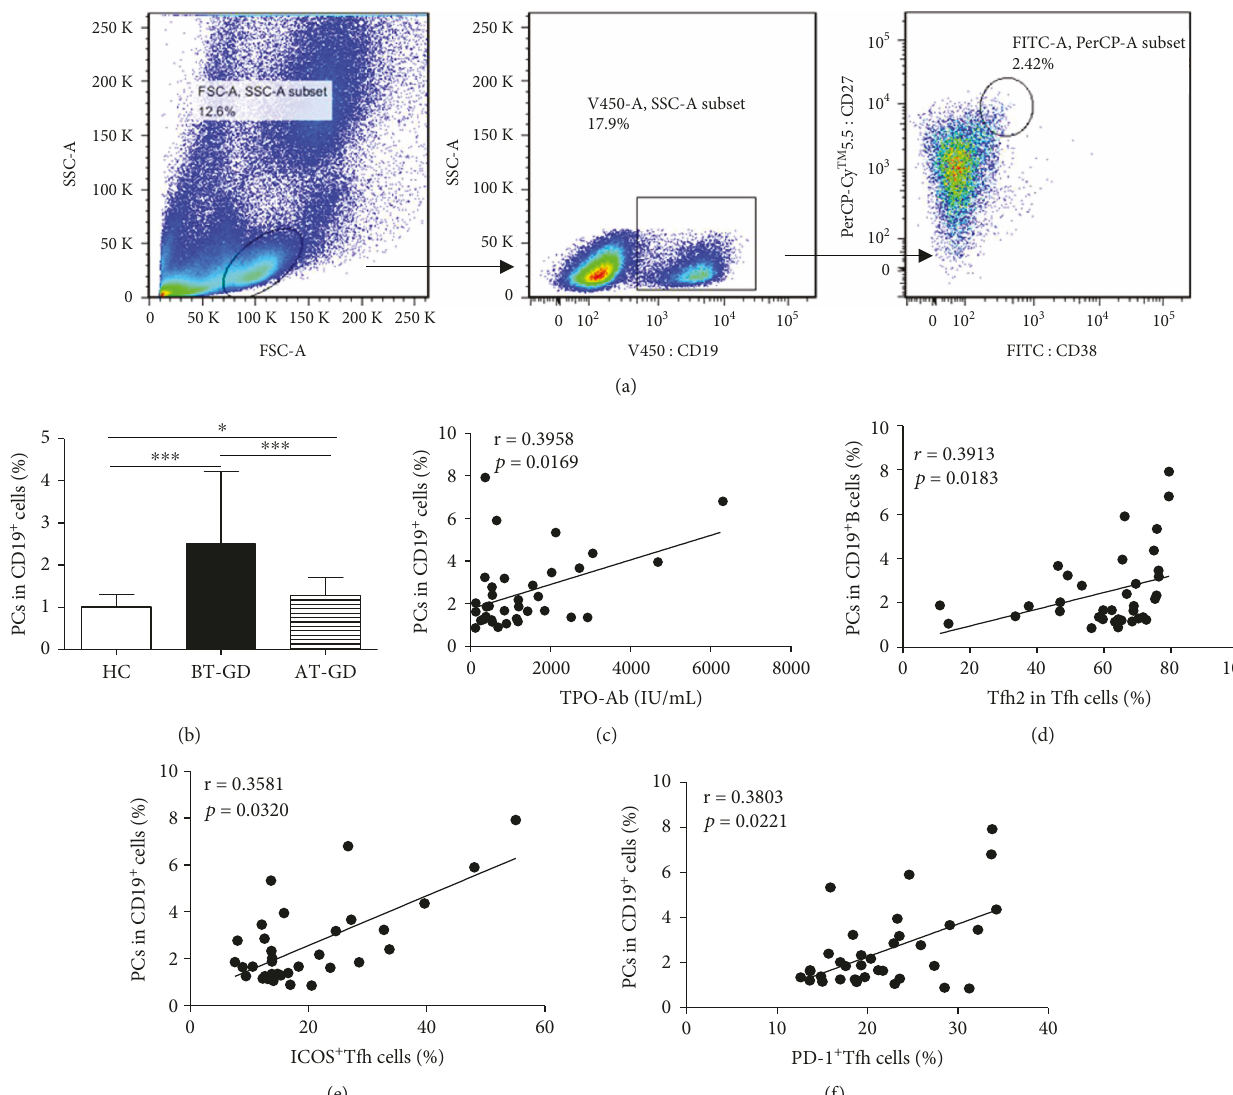
Figure 3: Expanded frequency of circulating plasma cells in GD patients. Human PBMCs from GD patients (BT: 36; AT: 21) and 20 HC were stained with anti-CD19, anti-CD38, and anti-CD27. (a) The cells were gated initially on lymphocytes and then on CD19 + B cells; afterwards, the numbers of CD27 high CD38 high PCs were analyzed by fl ow cytometry. (b) Changes in PCs in GD patients. (c) Relation of PC proportions and serum TPO-Ab levels in GD patients. (d) Relation of Tfh2 subset proportions with PCs in GD patients. (e) The correlation between the proportions of PCs and ICOS + Tfh cells in GD patients. (f) The correlation between the proportions of PCs and PD-1 + Tfh cells in GD patients. ∗ p < 0 05 , ∗∗ p < 0 01 , and ∗∗∗ p < 0 001 ; ns: no signi fi cant di ff